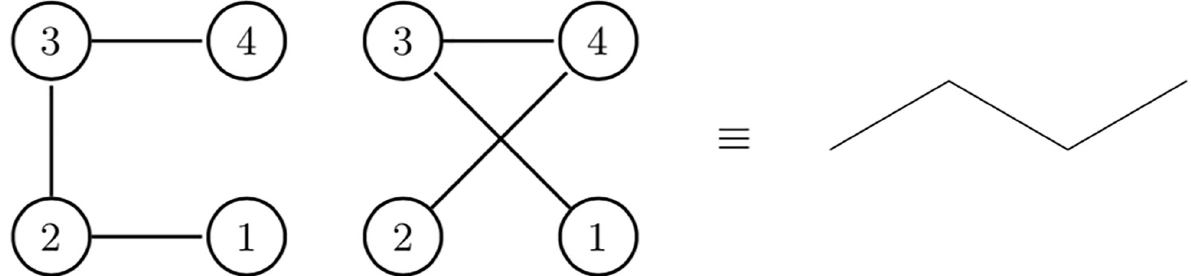
Fig 1. Isomorphism of trees. Two isomorphic tree graphs with degree sequences (1,2,2,1) (left) and (1,1,2,2) (middle) that both correspond to the straight chain isomer (right) of C 4 H 10 .